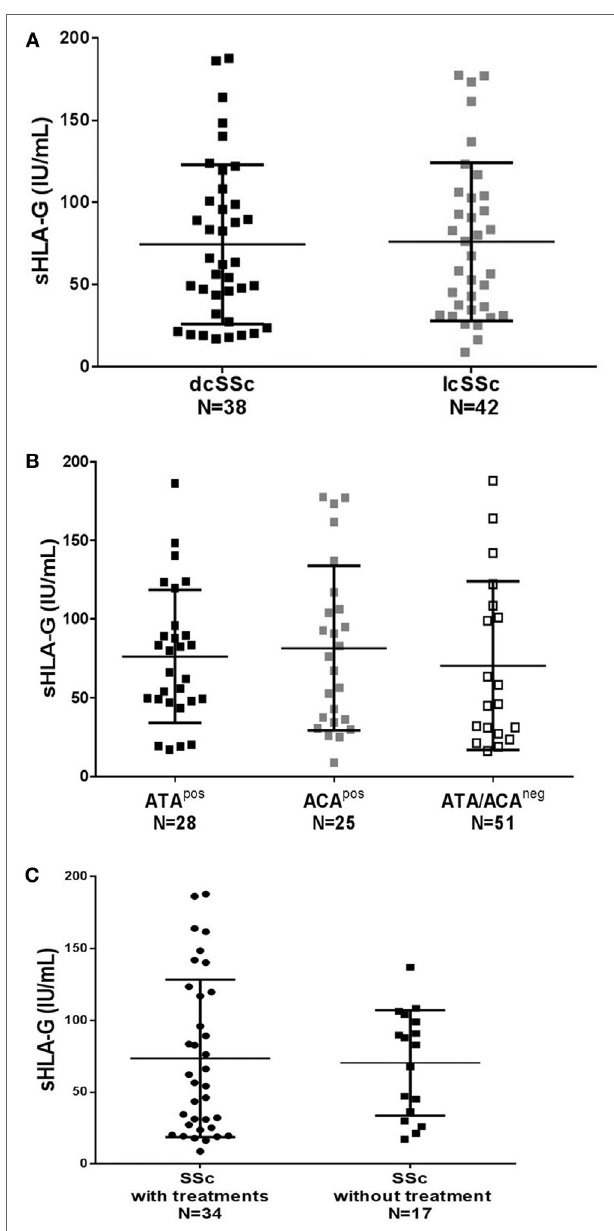
FigUre 2 | Quantification of soluble HLA-G (sHLA-G) in plasma from women with SSc divided according to (a) their clinical status: black squares represent values for women with diffuse cutaneous SSc (dcSSc), gray squares represent values for women with limited cutaneous SSc (lcSSc); (B) their autoantibody status: black squares represent values for women with SSc positive for anti-topoisomerase antibodies (ATA pos ), gray squares represent values for women with anti-centromere antibodies (ACA pos ), and white squares represent values for women negative for both autoantibodies (ATA/ACA neg ); and (c) their treatments: black circles represent values for women who are under immunosuppressive therapies and/or anti- inflammatory medications, labeled “with treatments”; black squares represent values for women who have only drugs to treat consequences of the disease and labeled “without treatments.” Means and SDs are given for each scatter plot by gray bars P values are calculated by Mann–Whitney test in (a,c) and one way-ANOVA test in (B) and are not significant for any of the graphs ( p = 0.85, p = 0.49, and p = 0.75,